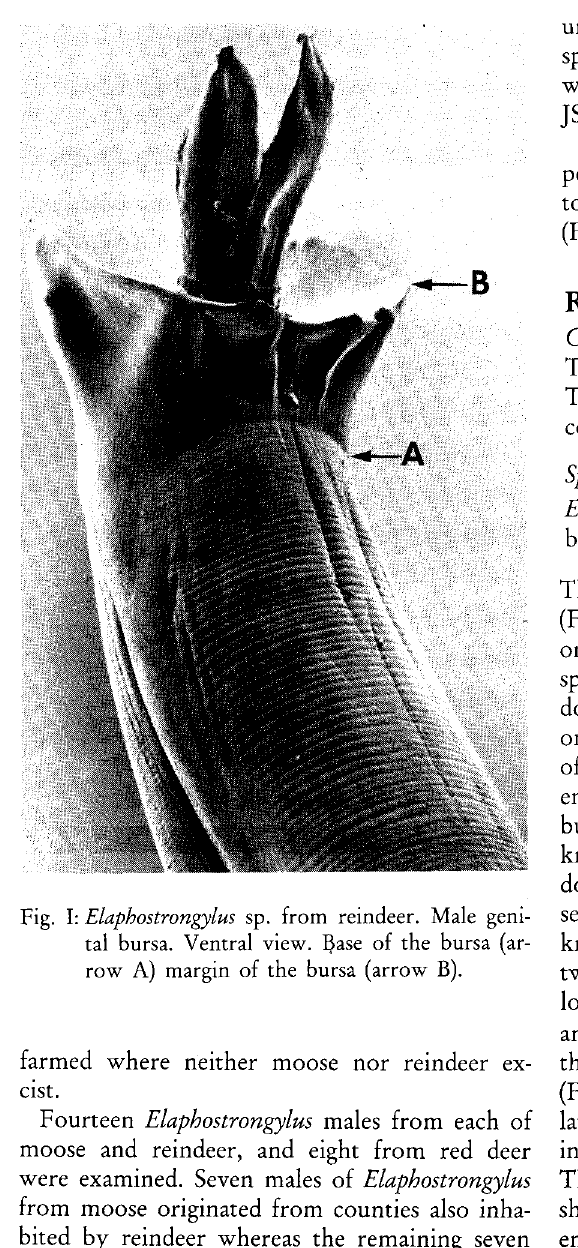
Fig. I: Elaphostrongylus sp. from reindeer. Male geni tal bursa. Ventral view. Base of the bursa (ar row A) margin of the bursa (arrow